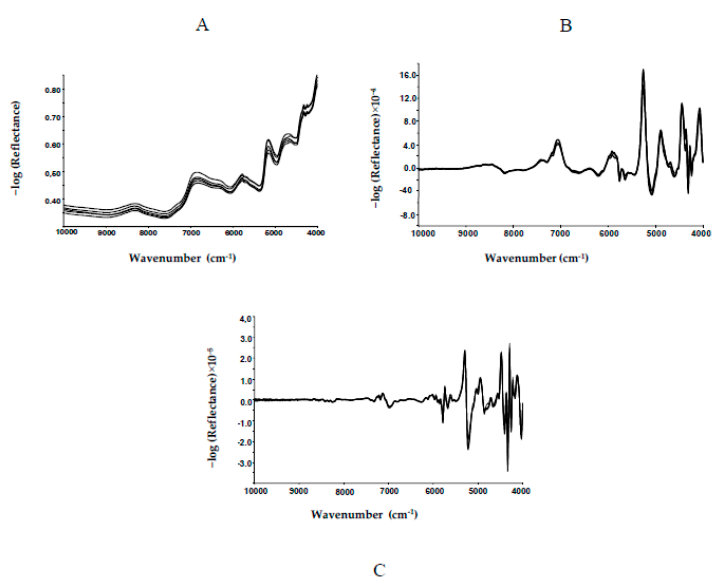
Figure 1. Near infrared spectra of olive tree pruning samples: ( A) Raw spectra, ( B ) first derivative Figure 1 . Near infrared spectra of olive tree pruning samples: ( A) Raw spectra, ( B) first derivative spectra; and ( C ) second derivative spectra; and ( C ) second derivative spectra.